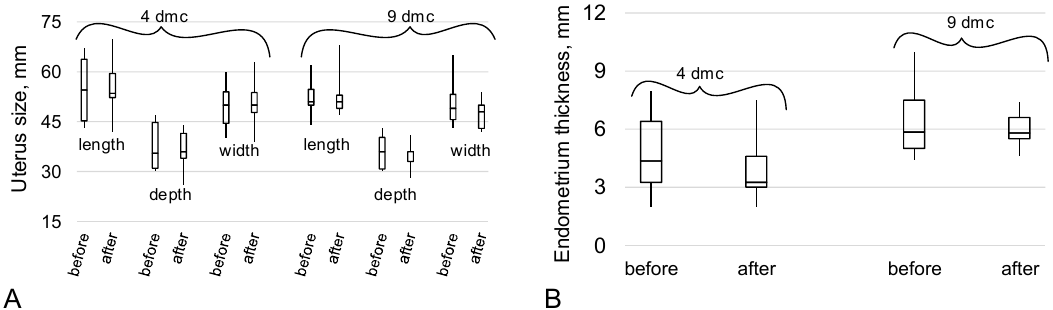
Figure 2. The size of the uterus ( A ) and the thickness of the endometrium ( B ) on the 4th and 9th days of the menstrual cycle (dmc) before and after a 5-day “dry” immersion. The average volume of the ovaries of the subjects on the fourth day of the menstrual cycle did not differ before and after the 5-day “dry” immersion. However, on the ninth day of the menstrual cycle, the ovarian volume after immersion decreased, on average, for the group; the median value after immersion was 22% lower ( p < 0.05) than before immersion (Figure 3A,B). The average diameter of the antral follicles on the fourth day of the menstrual cycle before and after immersion did not differ significantly, but on the ninth day of the cycle after immersion, it increased by 14% ( p < 0.05), as did the diameter of the dominant follicle by 22% ( p < 0.05).